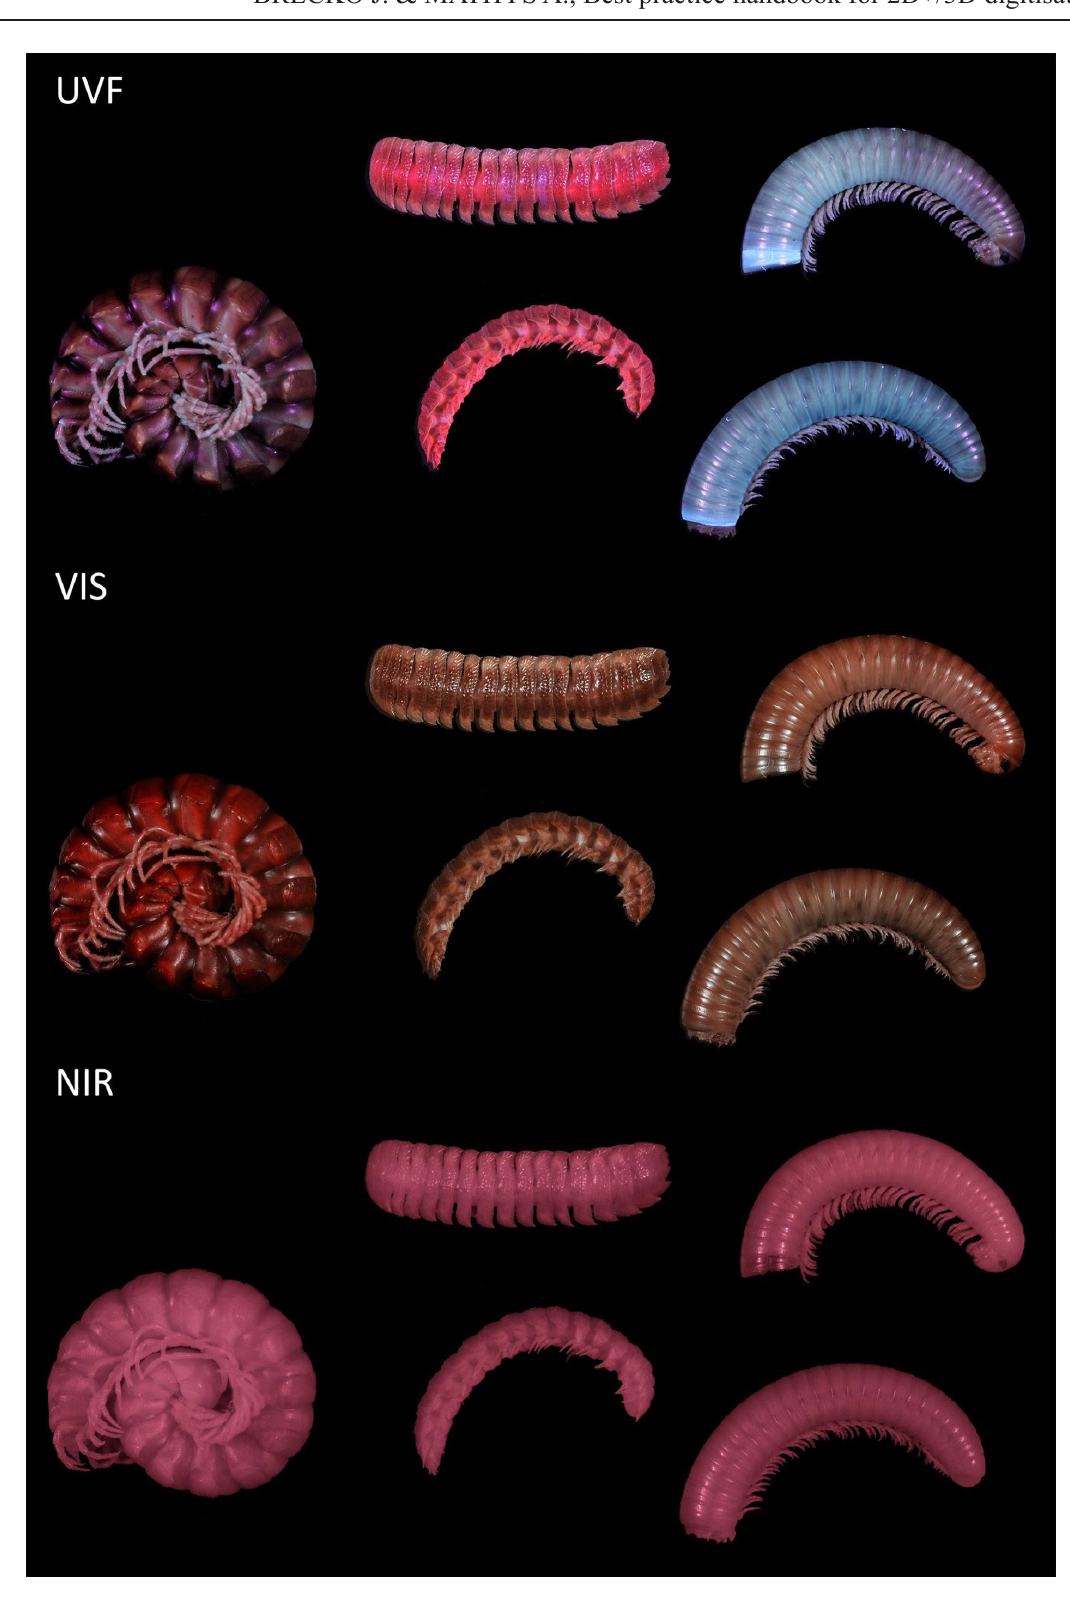
Fig. 4.3. Diplopods in UV fluorescence on top, in white light in the middle, in NIR at the bottom. UV fluorescence show that diplopods can fluoresce in different ways (blue, orange or not at all). NIR show the diplopods without the external pigmented